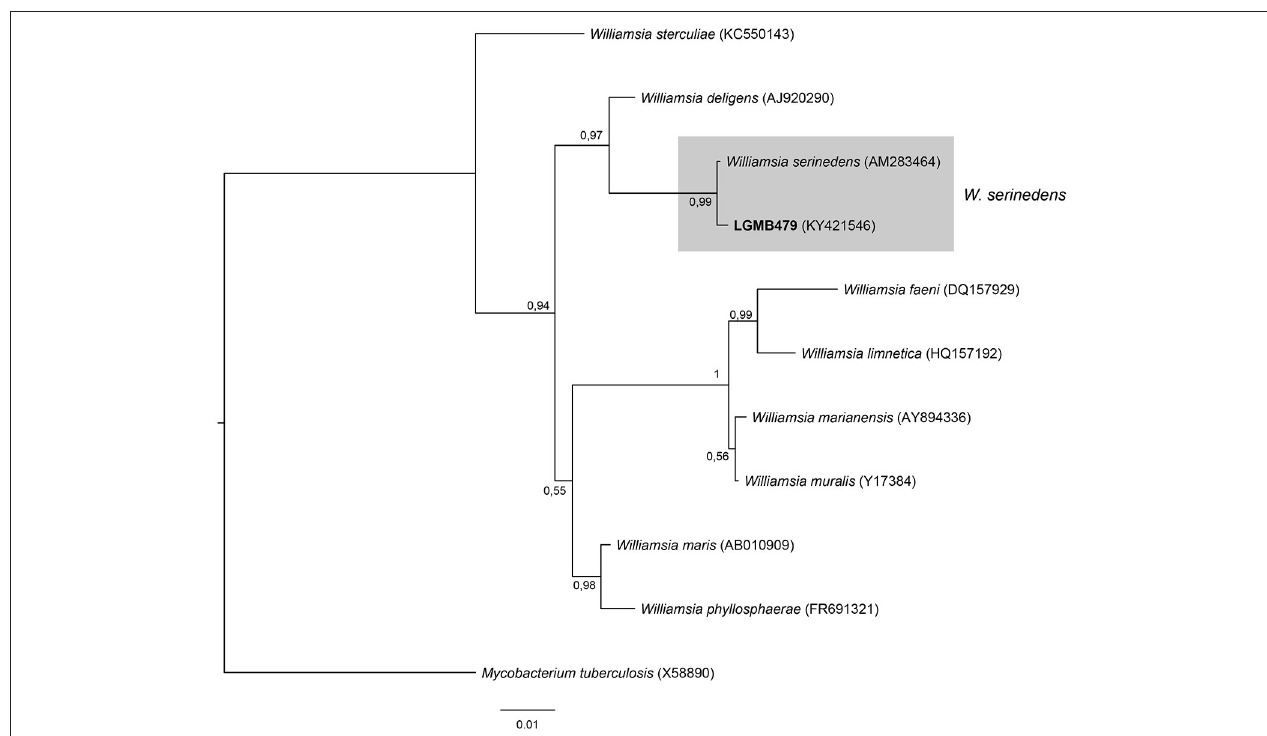
FIGURE 8 | Bayesian phylogenic tree based on 16S rRNA gene of LGMB479 and the 9 type strain of Willamsia genus. Values on the node indicate Bayesian posterior probabilities. The species Mycobacterium tuberculosis was used as out group. Scale bar indicates the number of substitutions per